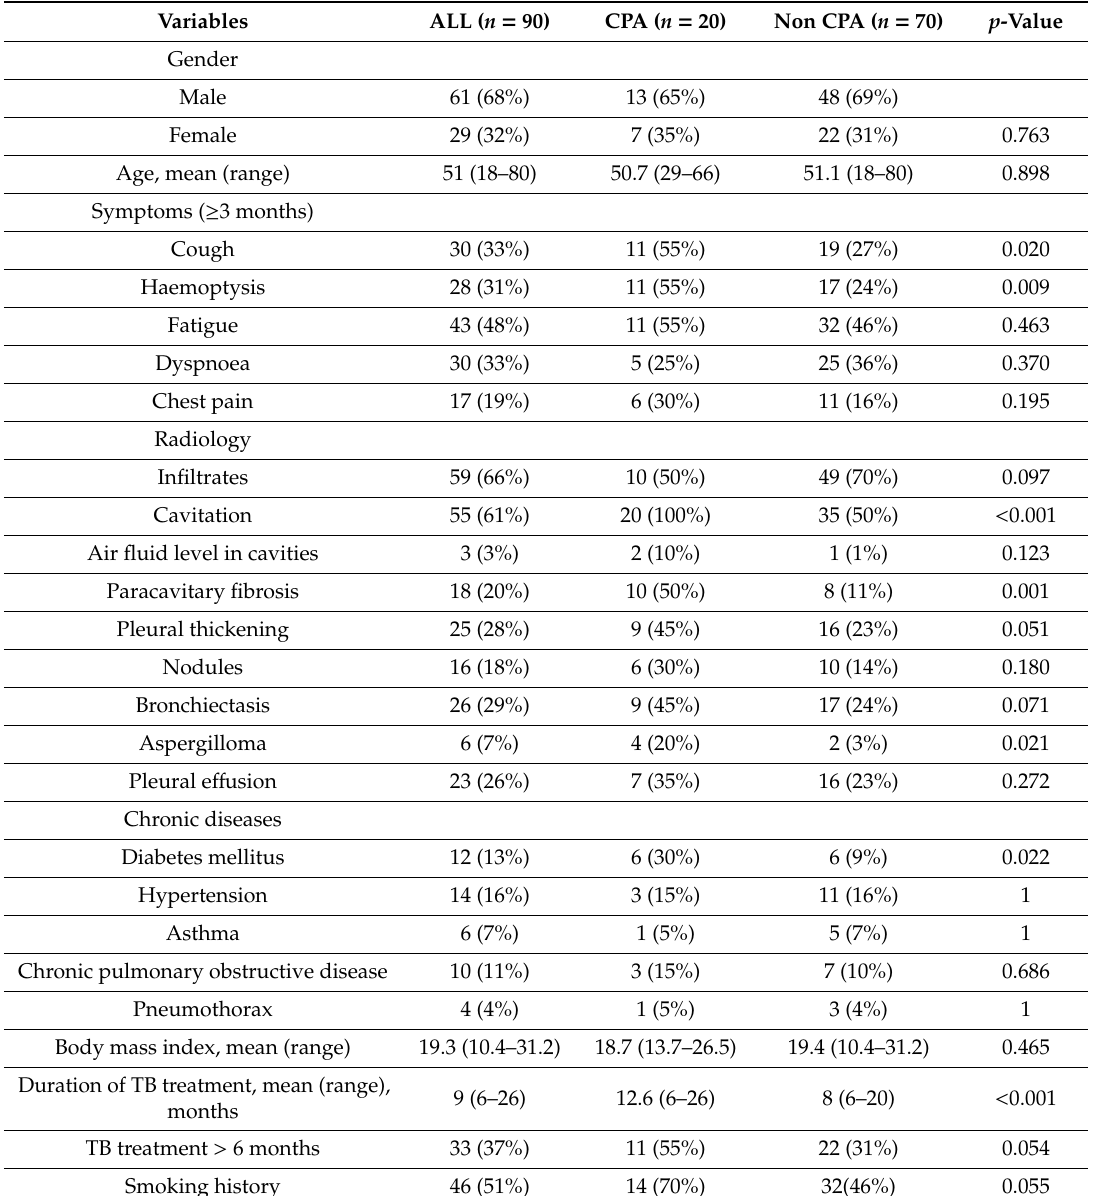
Table 1. Patient